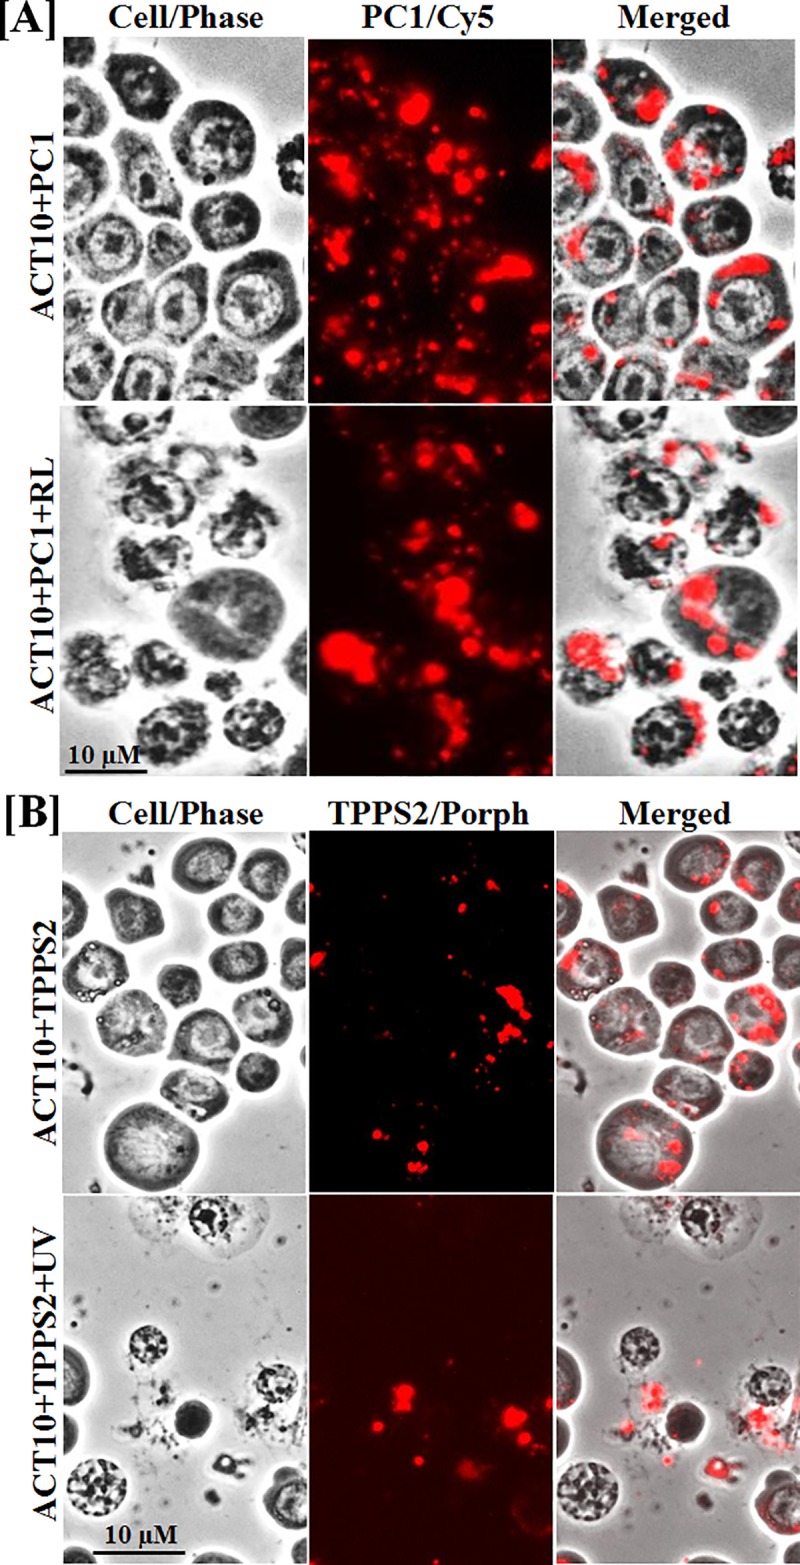
Uptake of representative phthalcyanine PC1 [A] and porphyrin TPPS2 [B] by Aedes cells effective to mediate their photo-inactivation and disintegration in vitro. See Materials and Methods for experimental details. Briefly, ACT10 cells were exposed in vitro to the photosensitizer (PS) in the dark overnight. One set was kept in the dark (Upper row: [A] ACT10+PC1 and [B] ACT10+TPPS2), while the other set was exposed to light at the PS-specific excitation wavelengths (lower row: [A] ACT10+PC1+RL and [B] ACT10+TTPS2+UV). Cell/Phase, Phase contrast microscopy to show cell integrity; PC1/Cy5, Cy5 filter set used to show PC1 fluorescence; TTPS2/Porph, Porphyrin filter set used to show TTPS2 fluorescence. Merged, phase contrast and fluorescence images merged to show uptake of both PS by the cells. Note: disorganization/disintegration of PS- and light-exposed cells in both cases (lower rows of [A] and [B]).